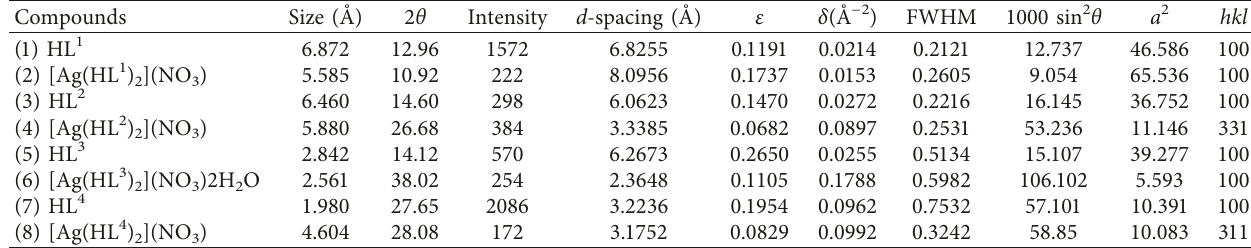
Table 3: XRD computed data for Ag(I)-pyrazolone (HL 1–4 ) complexes. Compounds Size (˚A) 2 θ